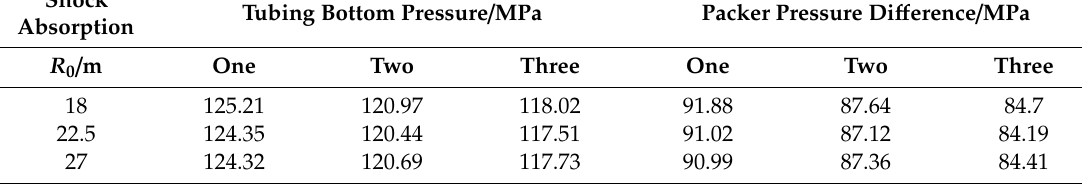
Table 5. Shock absorption with di ff erent number of shock